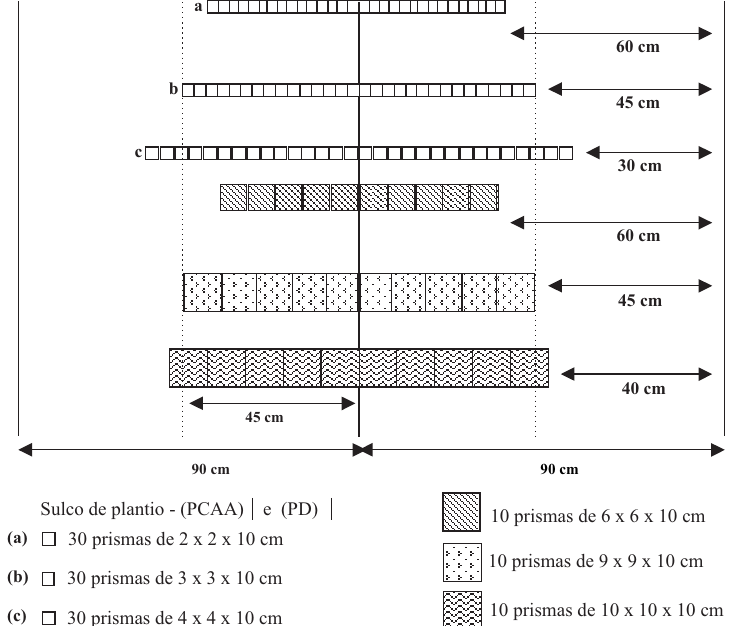
Figura 1. Esquema de coleta de amostras simples de solo com seis volumes diferentes (40, 90, 160, 360, 810 e 1.000 cm 3 ), correspondendo, respectivamente, a prismas de base quadrada medindo 2, 3, 4, 6, 9 e 10 cm de lado por 10 cm de profundidade, em duas situações de preparo-coleta (PD e PCAA). No PCDA, a amostragem foi realizada da mesma maneira, mas sem poder considerar a localização do sulco, devido à aração-gradagens do